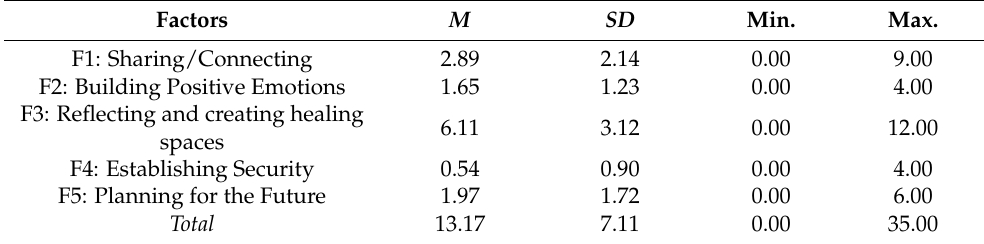
Table 4. Factor descriptive data.